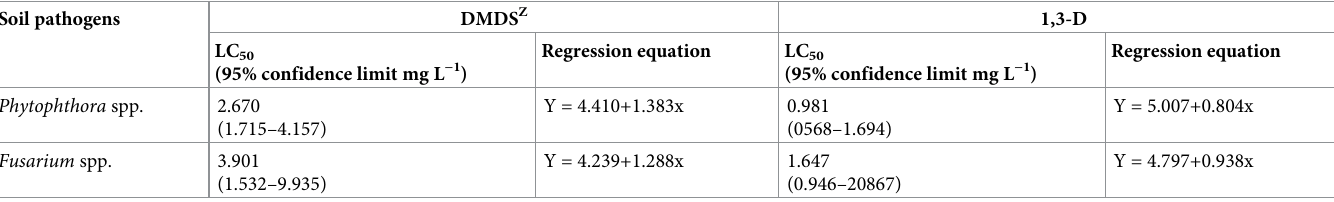
Table 4. Dose response result of soil pathogens to DMDS and 1,3-D with the soil fumigation method. Soil